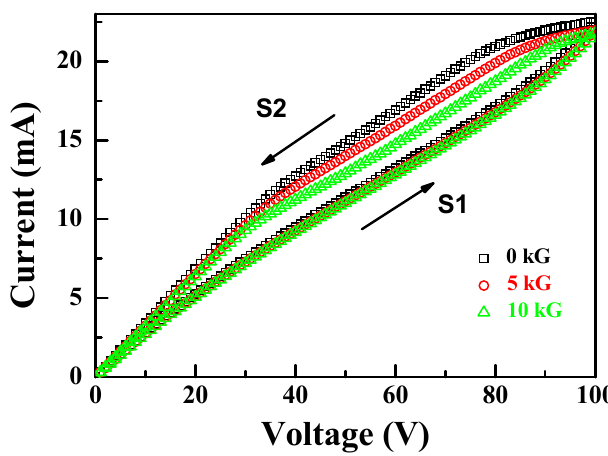
Figure 6. Magnetic SCE–RS loops. Red, green, and blue data are SCE–RS loops measured in an 8 mm, n-doped, Si device (1126-1#) under the magnetic fields of 0, 5, and 10 kG at room temperature. Black arrows illustrate the sequence of voltage applied.